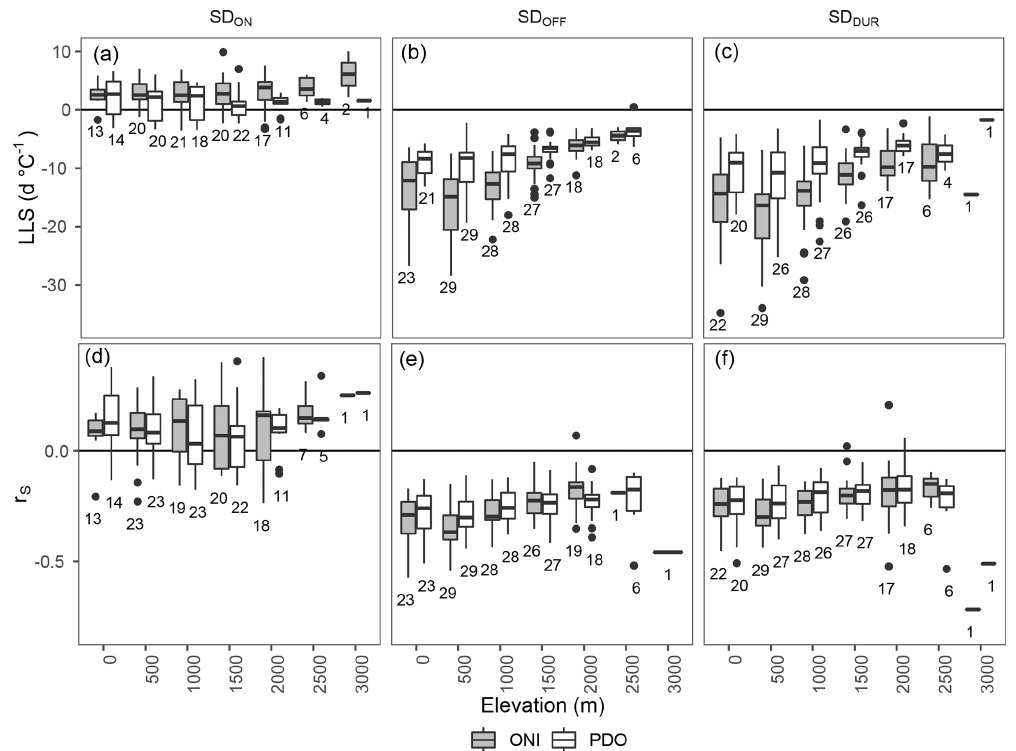
Figure 11. Linear least squares (LLS; a, b, c ) and Spearman correlation coefficients ( r S ; d, e, f ) per hydrozone for SD ON , SD OFF , and SD DUR with ONI and PDO in 500m elevation bins. Only correlations with p values ≤ 0 . 05 are shown. Box plots represent the median (black horizontal line in box), the 25th and 75th percentile ranges (box limits), and the 5th and 95th percentile ranges (whiskers), with outliers shown as black points. The sample size of each box is shown below it with a maximum of 29 values (one per